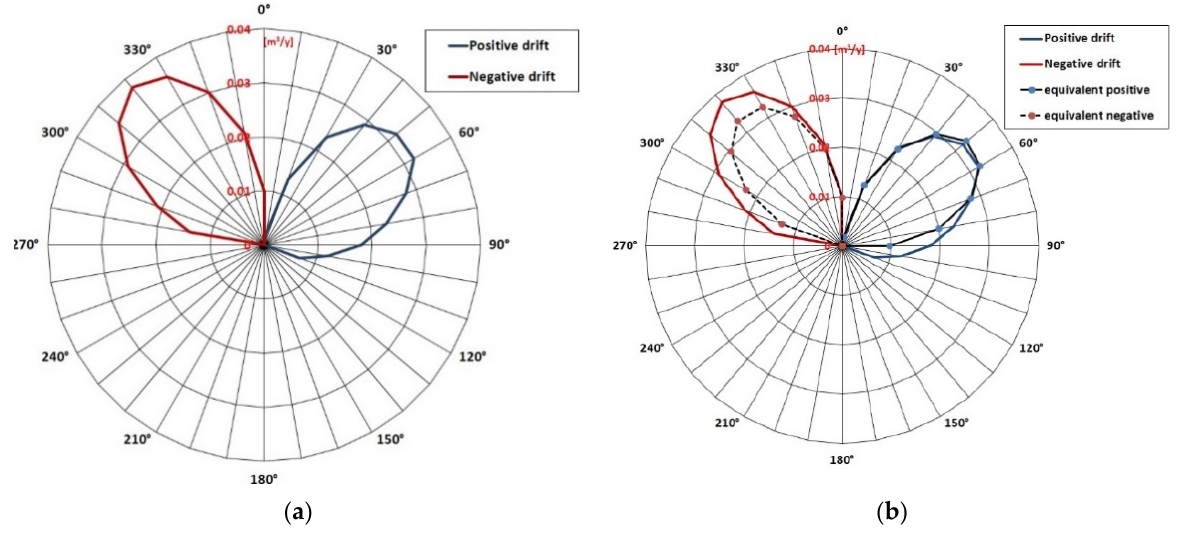
Figure 8. ( a ) Net littoral drift rose of Molise coast; the blue line represents drift to right when looking offshore, while the red line represents drift to left when looking offshore; ( b ) comparison between Total- and Equivalent-LDRs of Molise coast. Littoral drift in cubic meters per year.